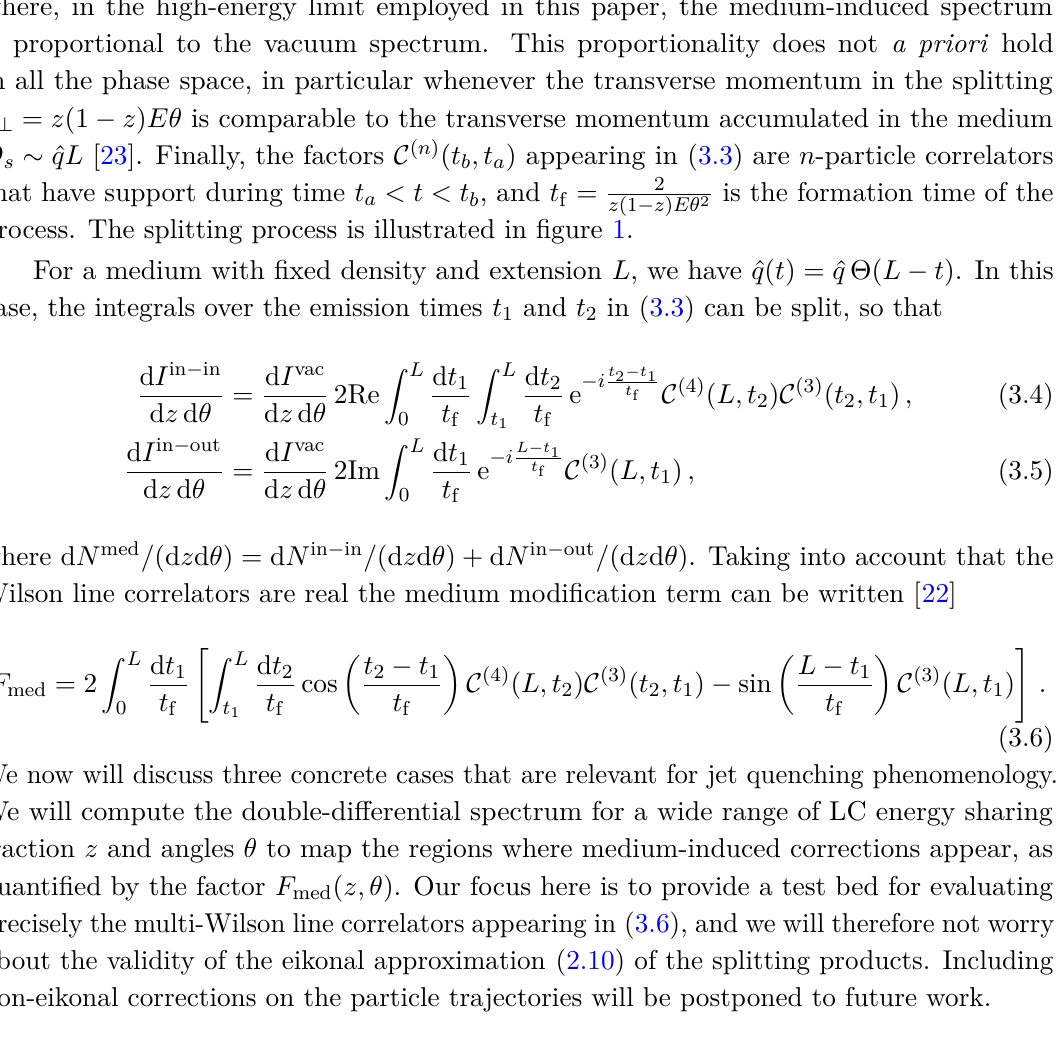
Figure 1. The process of a photon splitting to a quark-antiquark pair. The amplitude is on the top and the complex conjugate amplitude on the bottom. The splitting happens at time t amplitude and at a later time t in the complex conjugate 2